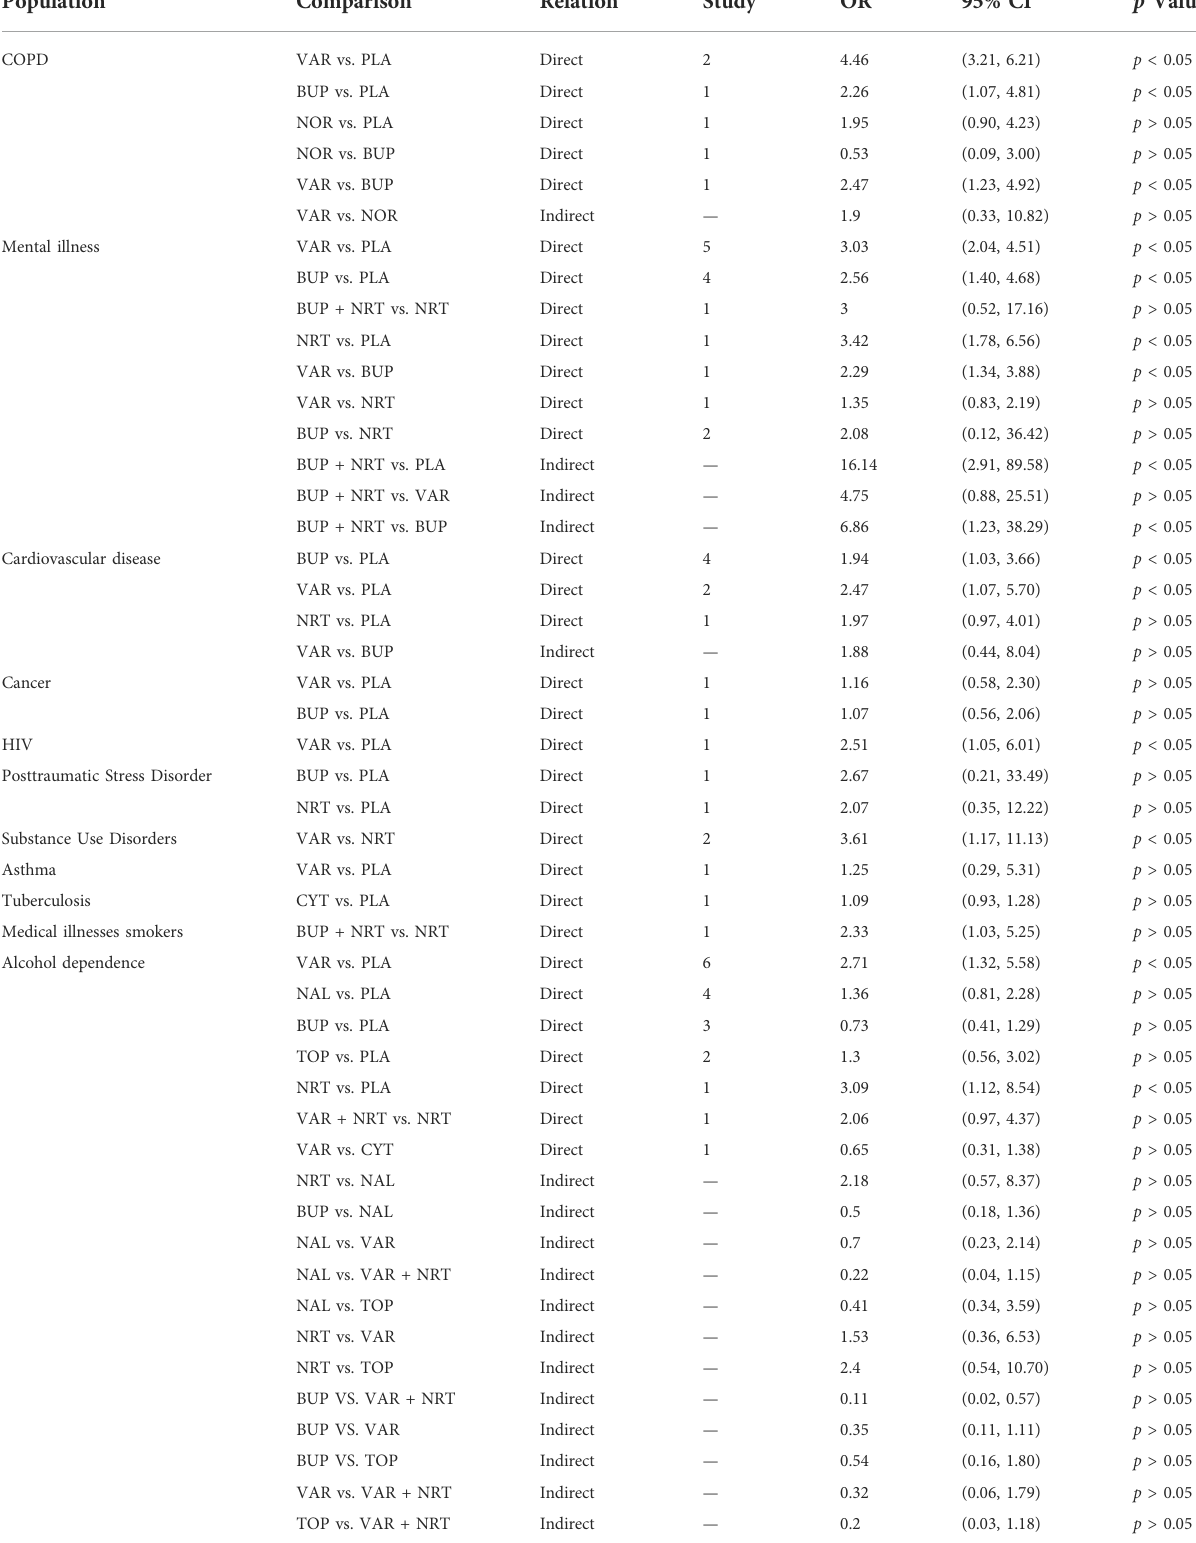
TABLE 3 Meta-analysis of smoking cessation effects of different interventions in speci fi c populations of smokers.